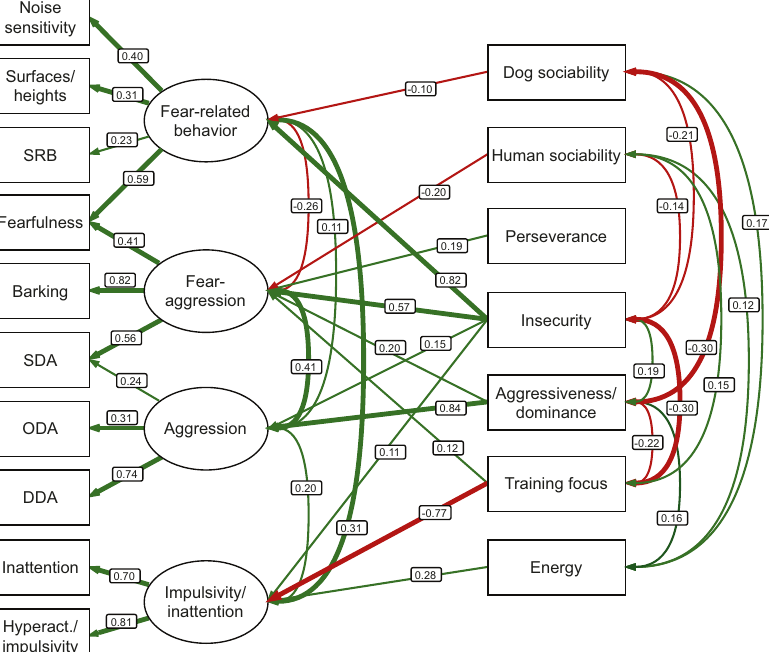
Fig. 1 Results of the structural equation modeling (SEM) analysis. Standardized estimates over 0.10 and under – 0.10 are included, with paths over 0.30 and under – 0.30 in boldface. Positive paths are in green and negative are in red. Covariates (age, sex, breed mean score, and socialization score) are omitted for clarity. All associations are found in Supplementary Tables S8 – S11. Surfaces/heights = fear of surfaces/ heights, SRB separation-related behavior, SDA stranger-directed aggression, ODA owner-directed aggression, DDA dog-directed aggression, Hyperact./impulsivity